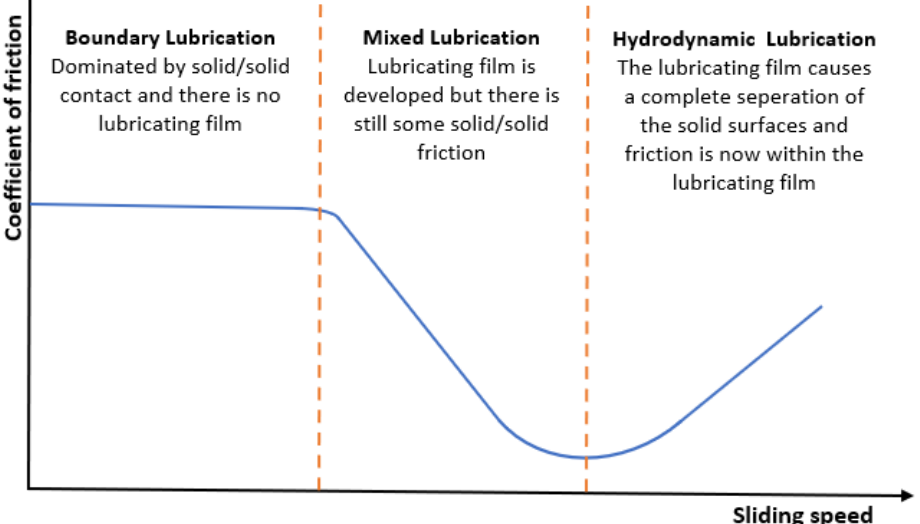
Figure 2. Stribeck curve for tribological profiling showing lubrication regions.